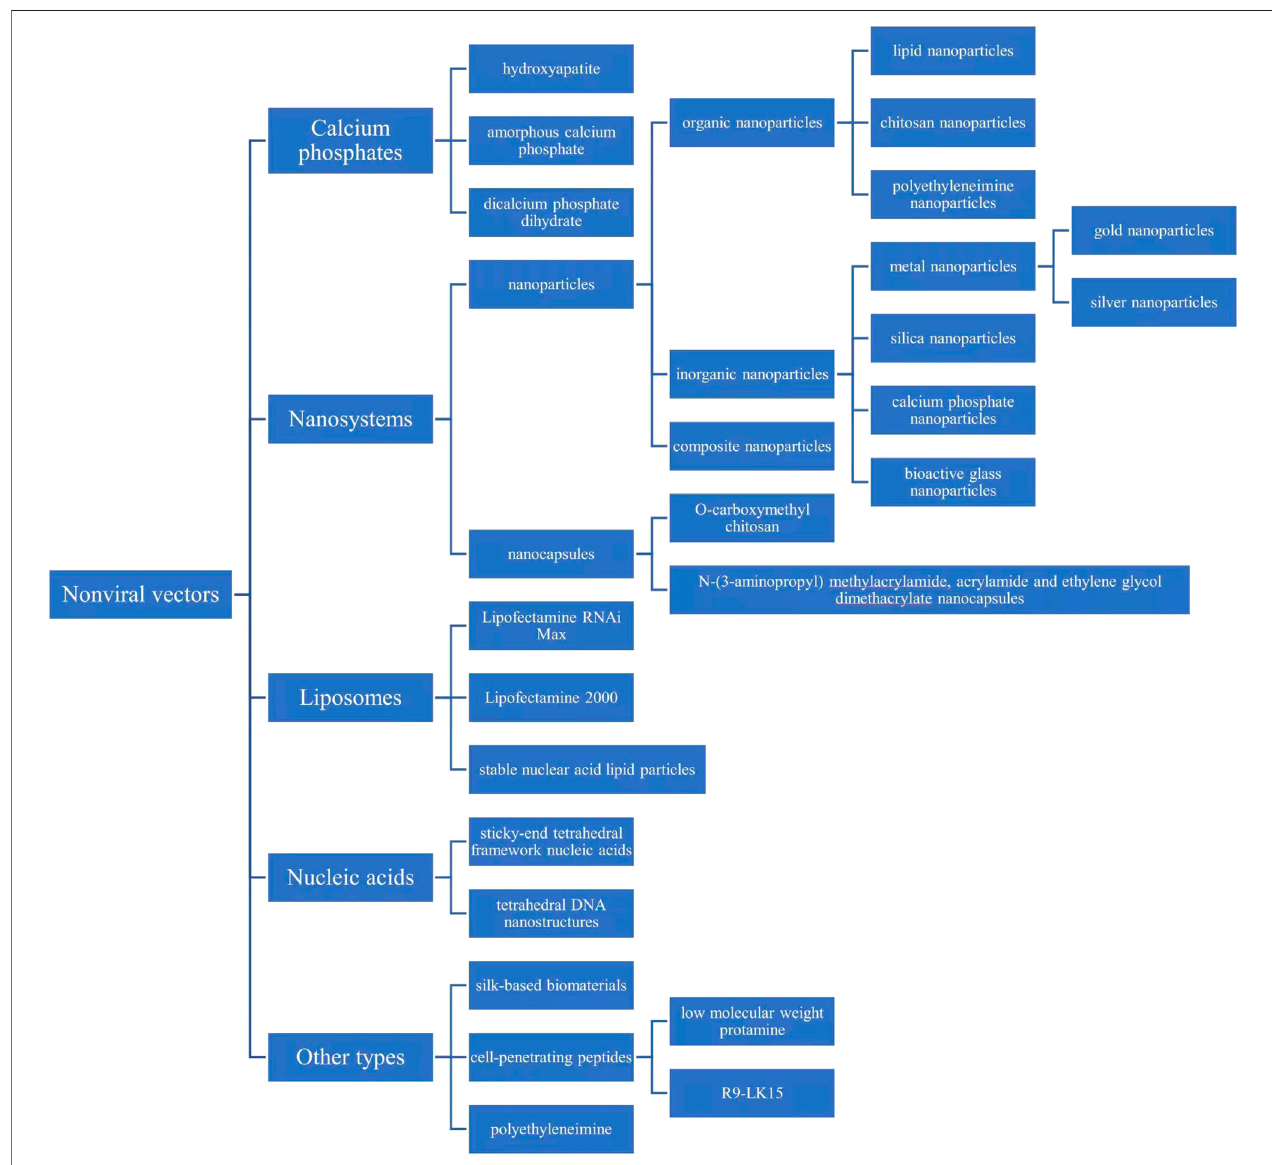
FIGURE 7 | Nonviral biomaterials for microRNA transfection in bone tissue engineering.